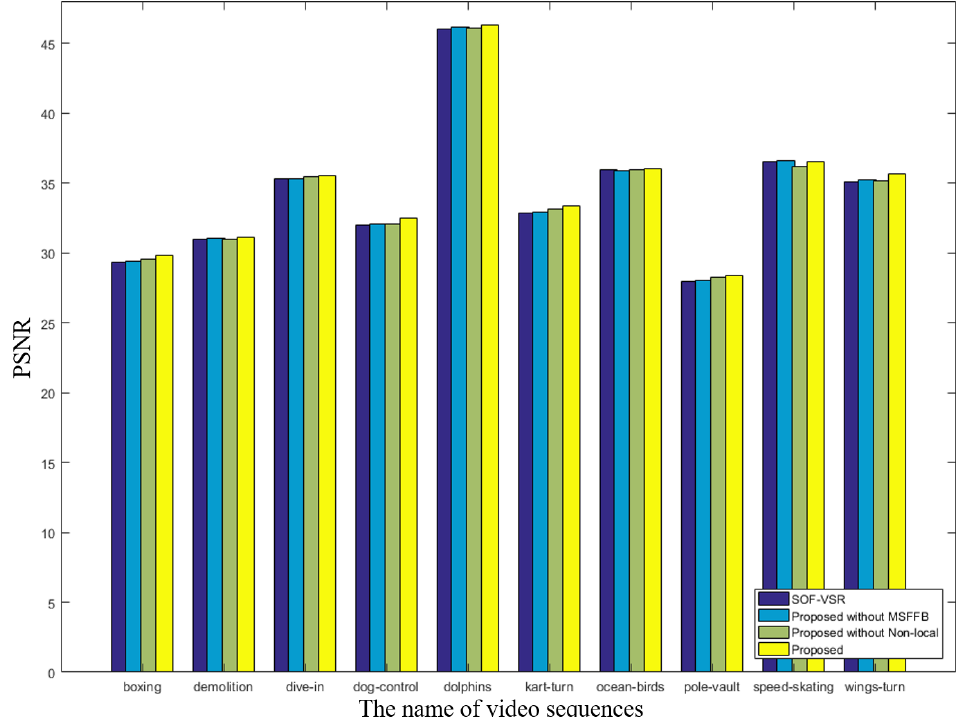
Figure 5. Reconstruction of different video sequences on DAVIS-10 dataset with × 4 scale, the reconstruction results of different methods are compared. The vertical axis represents the PSNR value and the horizontal axis represents the video frame